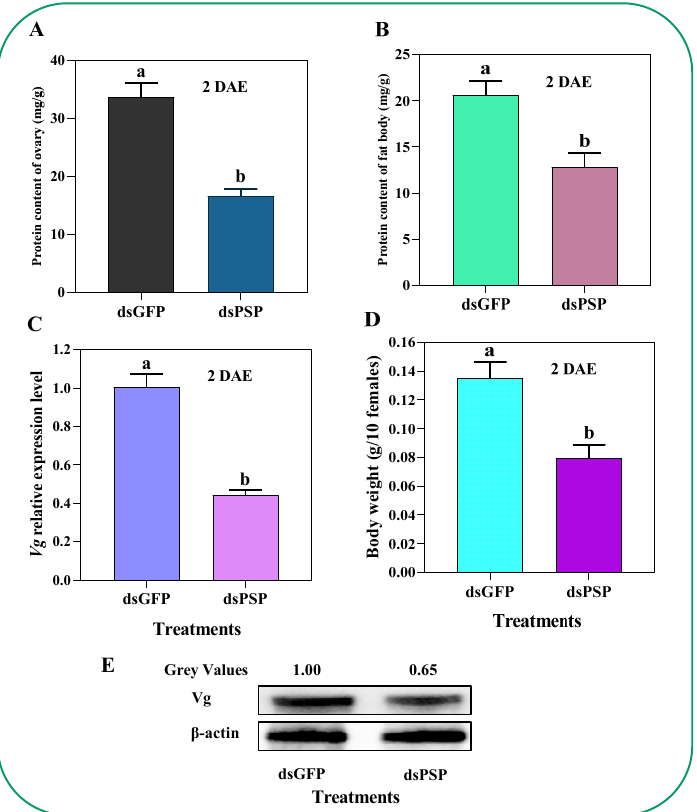
Figure 7. Silencing of PSP gene by dsPSP injection treatment led to a significant reduction in total ovarian ( A ) and fat body protein concentrations ( B ) in C. lividipennis female adults. The same treatments also reduced Vg expression ( C ) and adult female body weights ( D ) compared to dsGFP-treated controls. ( E ) Mean Vg protein concentration in whole fat bodies, determined by the Western blot. The histogram bars represent the means ± SEM. Histogram bars annotated with different lowercase letters were significantly different ( p < 0.05). Grey values were normalized to β -actin; DAE is days after emergence.